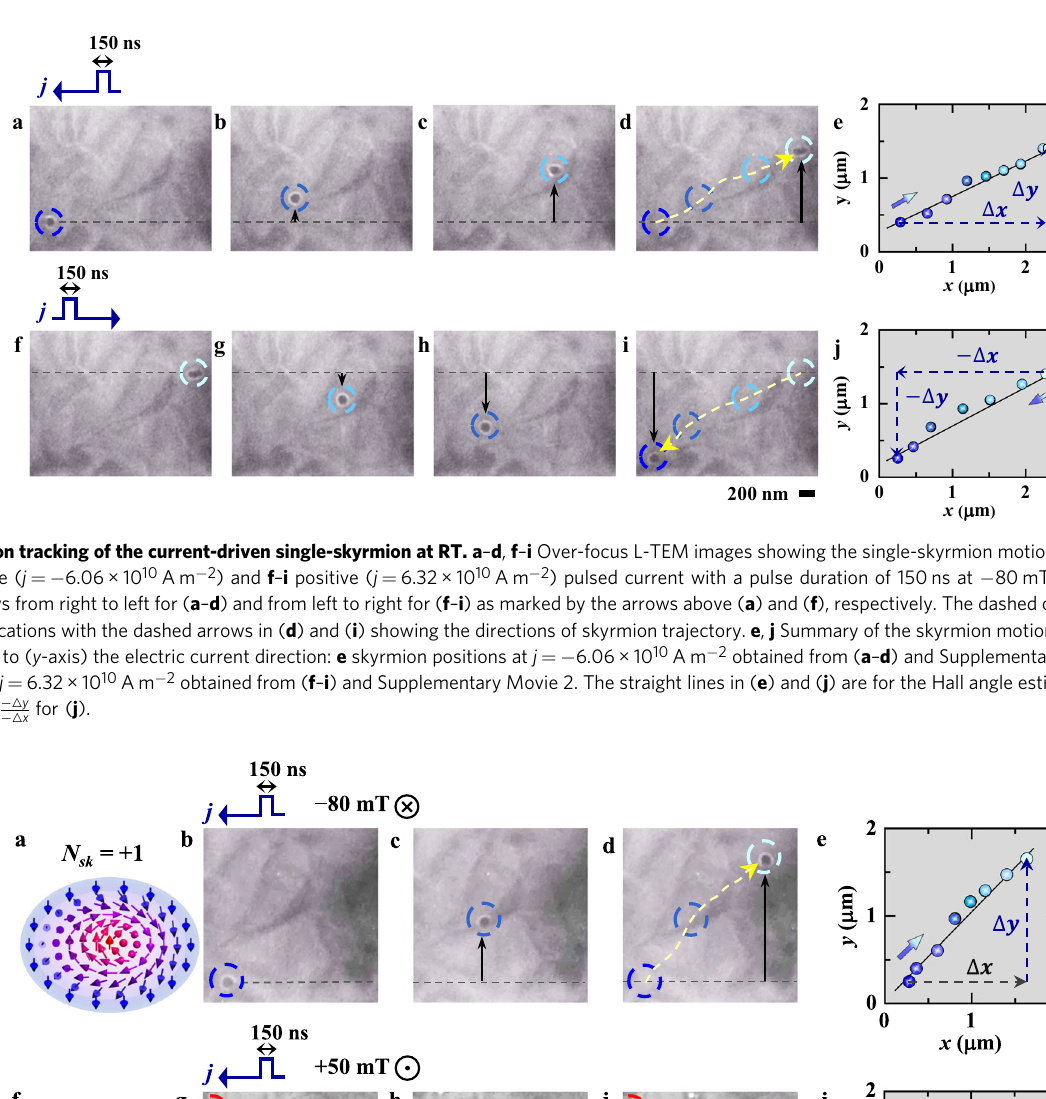
the skyrmion with N sk = + 1 moves from the lower-left corner to the upper-right corner at j ¼ (cid:3) 5.05 × 10 10 A m − 2 (Fig. 3b – d), while the skyrmion with N sk = − 1 moves from the upper-left corner to the lower-right corner at j ¼ − 4.82 × 10 10 A m − 2 (Fig. 3g – i). Figure 3e, j summarize the locations of N sk = + 1 and − 1 skyrmions, respectively, revealing the same direction of their translational motion and the opposite direction of their Hall motion.